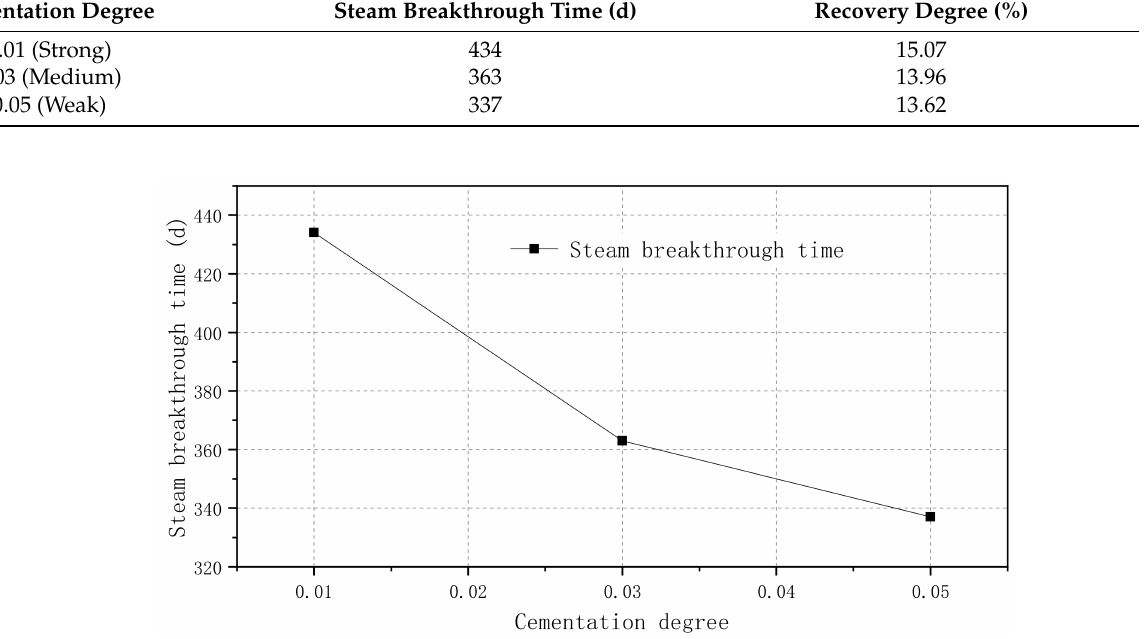
Figure 18. Steam breakthrough time for different cementation degree.